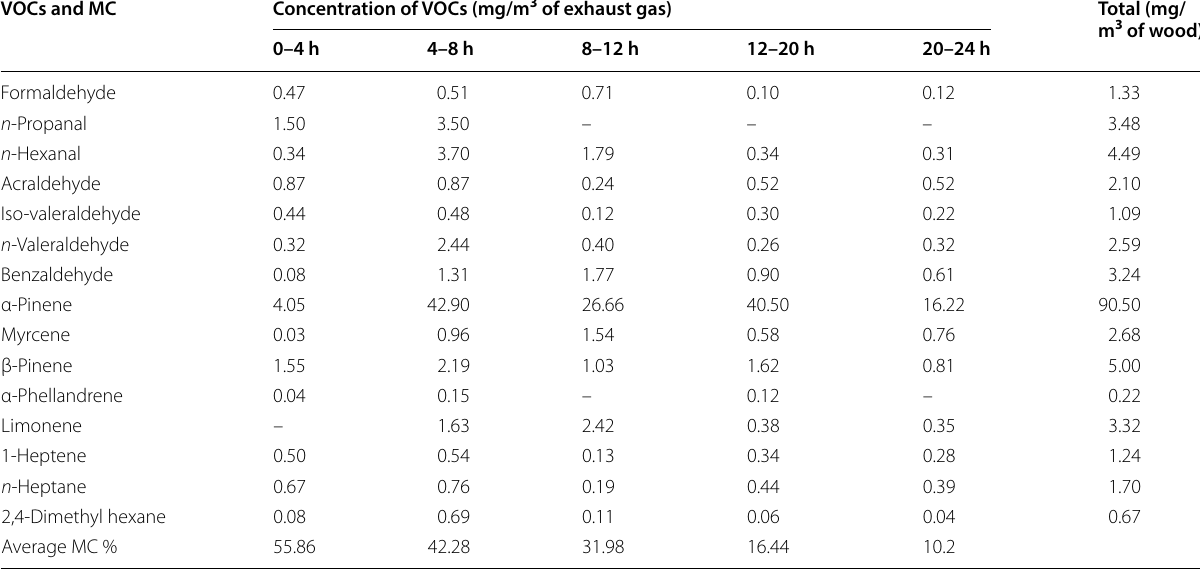
Table 4 Constituents and amount of VOCs released during each period of conventional drying (Russian Pinus sylvestris ) VOCs and